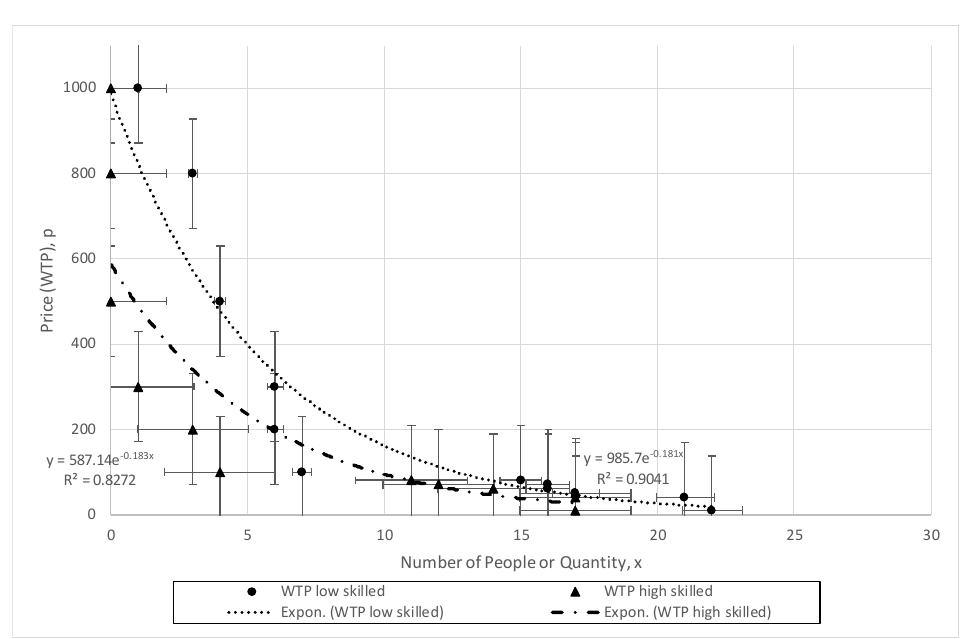
Figure A1. Willingness-to-pay (WTP) for high- and low-skilled for Google.